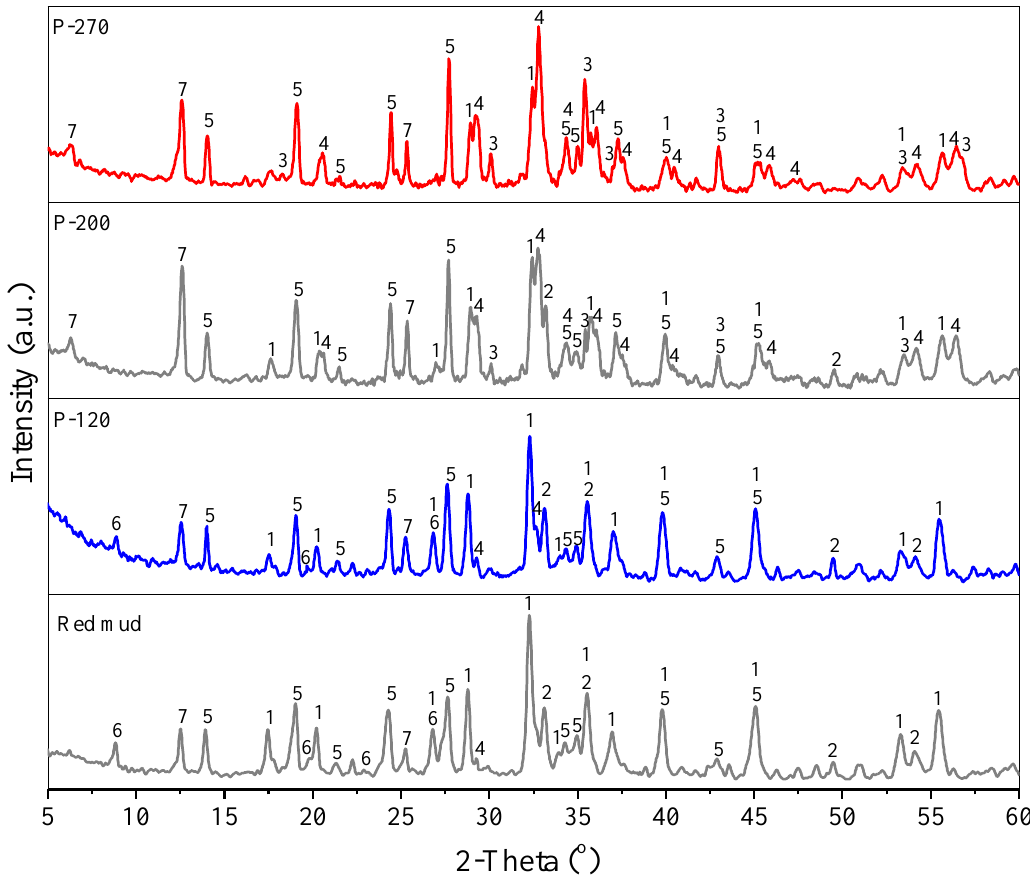
Figure 1. X-ray powder diffraction (XRD) patterns of the red mud, P-120, P-200 and P-270. In the figure, the peak was numbered: 1: andradite; 2: hematite; 3: magnetite; 4: Morimotoite; 5: cancrinite; 6: muscovite; 7: clinochlore.